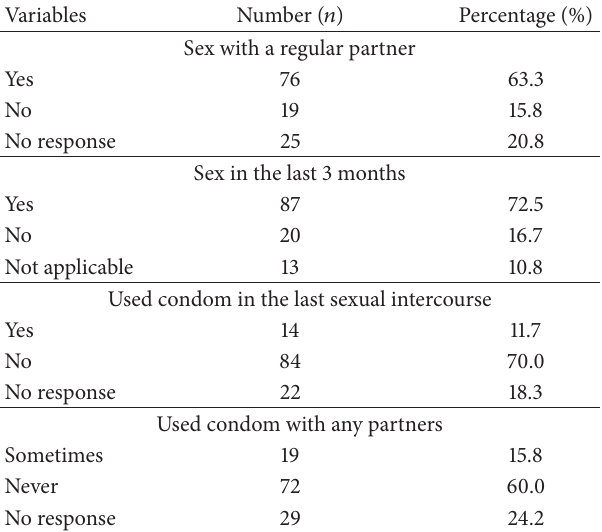
Table 5: Sexual behavior of the